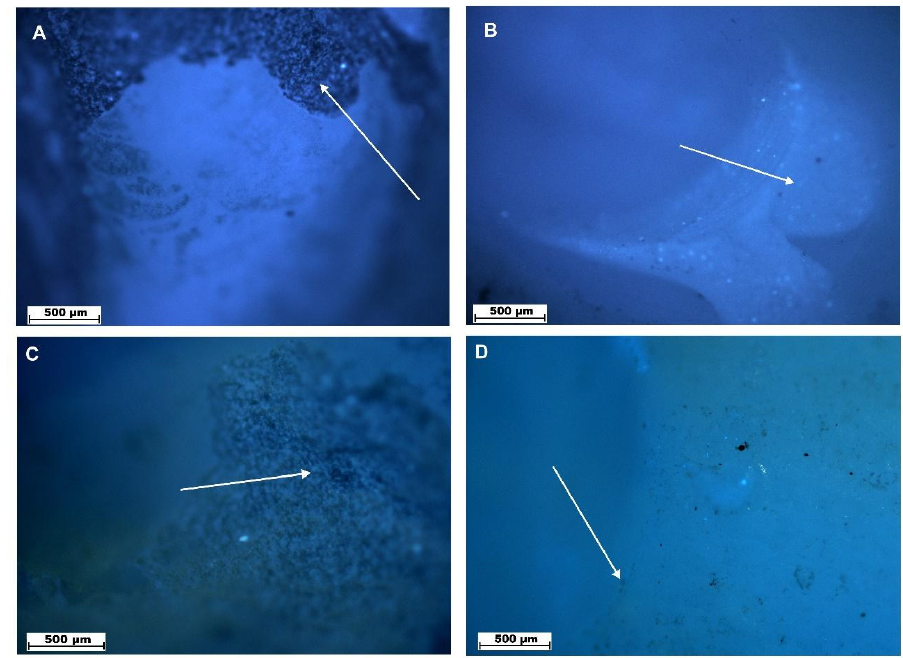
Figure 3. Surfaces of teeth after laser ( A , C ) and drill treatment ( B , D ) examined by fluorescence microscope, magnification 40×.